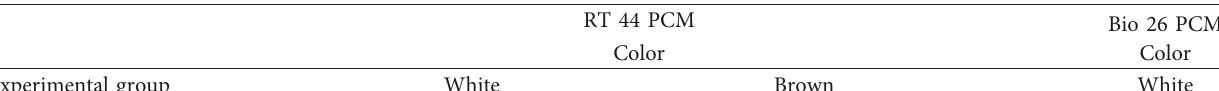
Table 8: Test 2 summary.